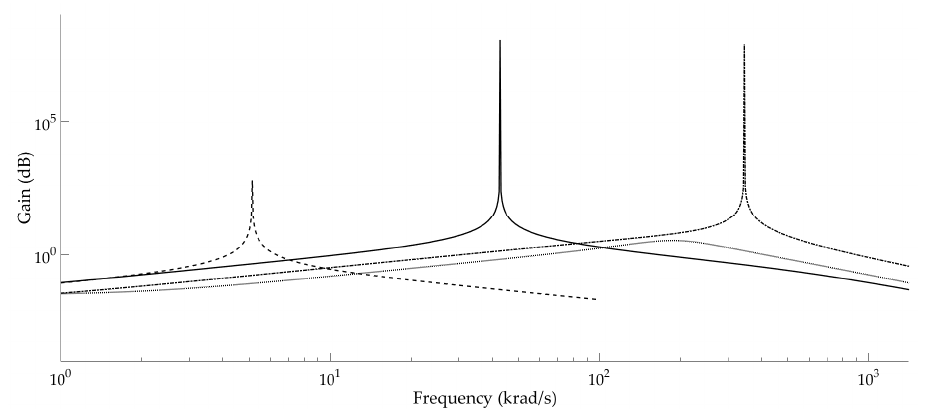
Figure 8. Amplitude–frequency characteristic for resistivity: control, solid line; nettle, dashed line; carrot, dot–dashed line; elderberry, dotted line.